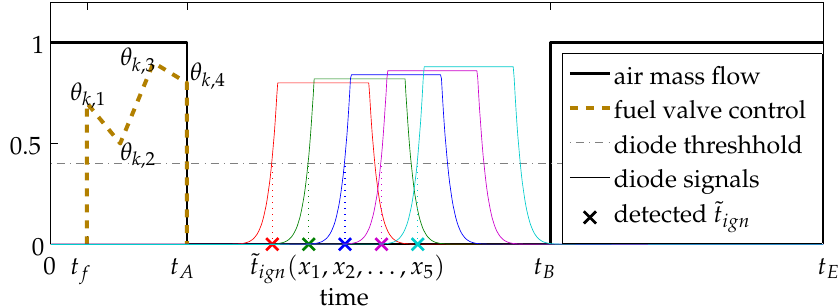
Figure 4. Example of one filling cycle showing the timings for the fuel and air injection and schematic photodiode